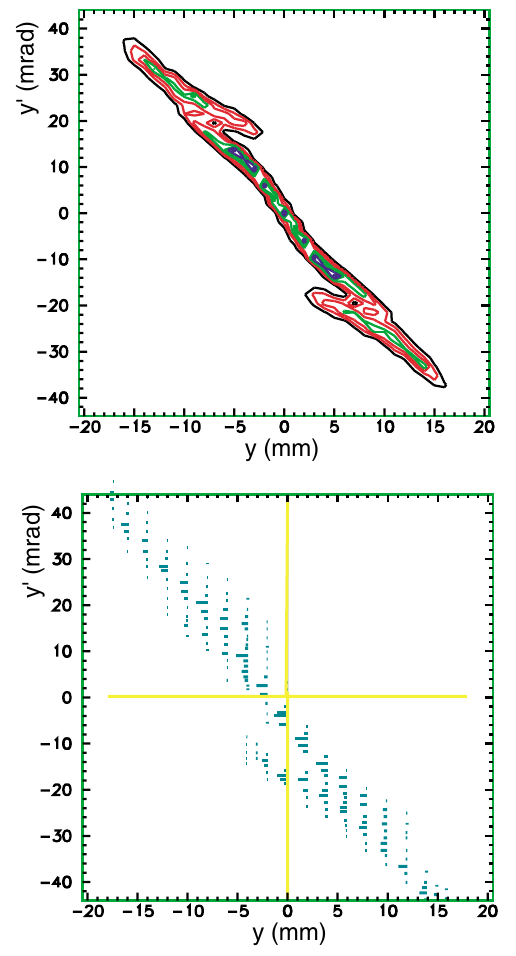
FIG. 6. (Color) Vertical phase space measurement (bottom panel) versus PIC simulation (top panel) at the d 3 diagnostic station. For the data, the length of the horizontal bar indicates the signal amplitude measured for the phase space coordinate at the right edge of each bar. For the simulation (10% contour intervals), the higher density region near y (cid:5) 0 , y 0 (cid:5) 0 in- cludes the distribution of two of the four merged beams in this projection of phase space.